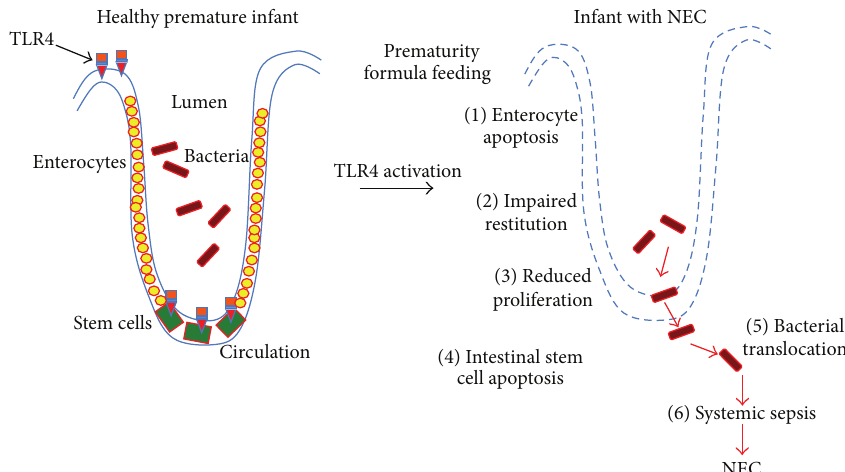
Figure 1: Mechanisms to explain how TLR4 activation in the premature intestinal epithelium is required in the pathogenesis of necrotizing enterocolitis. As shown, colonization of the intestine of the premature infant leads to the activation of TLR4 within the intestinal epithelium as well as on the intestinal stem cells, due in part to the elevated expression levels of TLR4 in the setting of prematurity. TLR4 activation leads to enterocyte apoptosis, impaired restitution and reduced proliferation as well as stem cell apoptosis, leading to bacterial translocation, systemic sepsis, and the development of NEC. See text for further